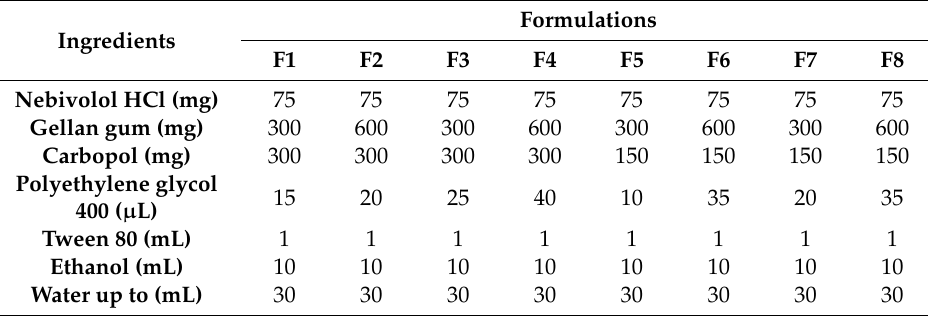
Table 1. Composition of nebivolol hydrogel formulations used in